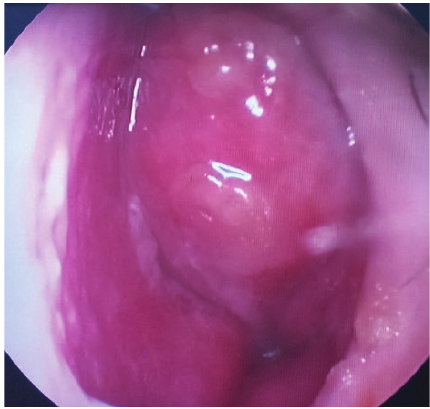
Figure 1: Endoscopic image of the mass in the left nasal meatus.